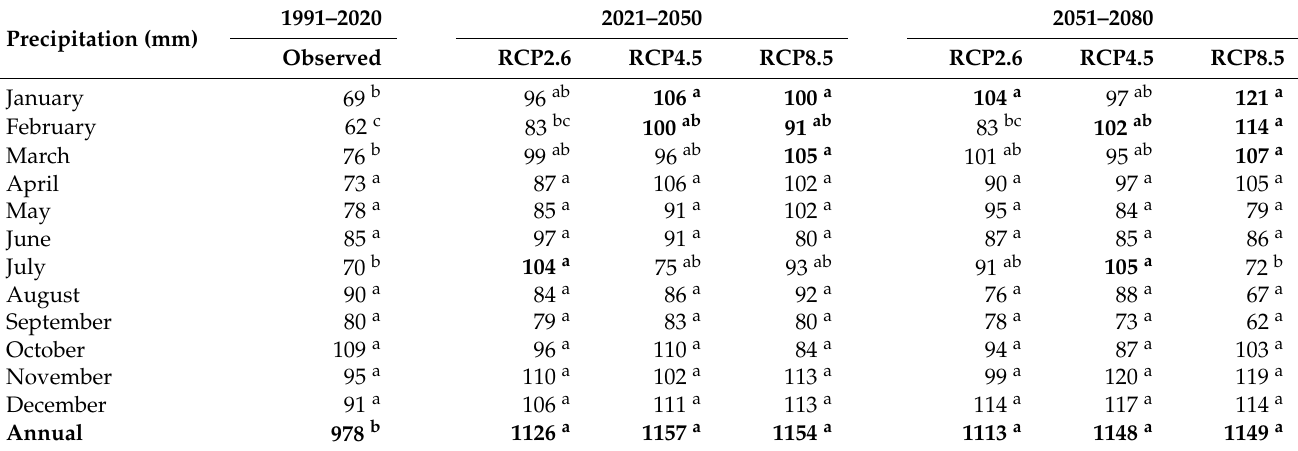
Note: Means that do not share a letter are significantly different at α = 0.05 (95% confidence) as per Tukey’s method. Bolded values highlight significantly different ones in the text, the annual are bolded because they represent sum total of all the